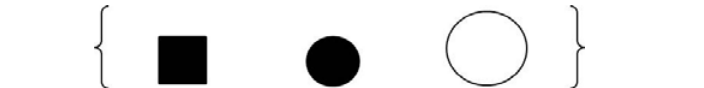
Figure 3. Category instance of (cid:1876)(cid:1877)(cid:1878) (cid:3397) (cid:1876) (cid:4593) (cid:1877)(cid:1878) (cid:3397) (cid:1876)′(cid:1877)′(cid:1878)′ concept